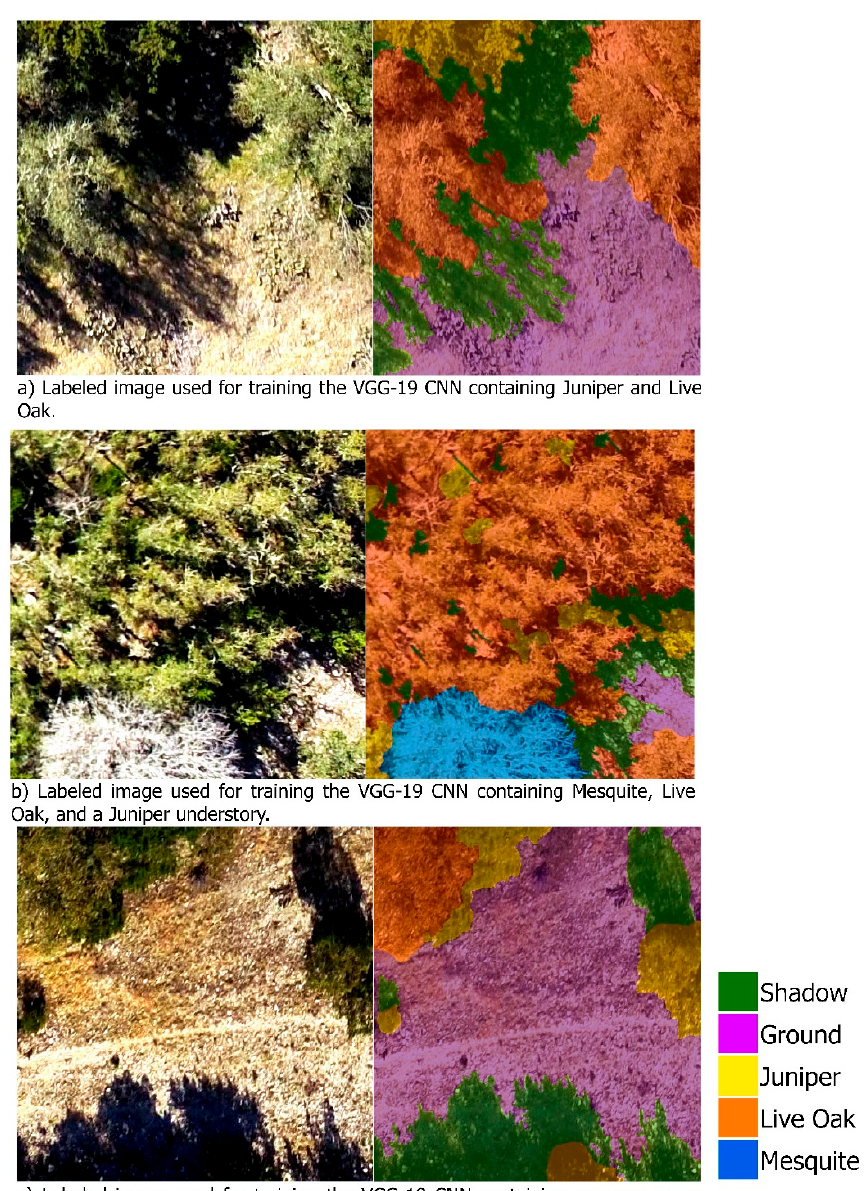
Figure 6. Labeled training images used to run the VGG-19 CNN. Images were carefully selected to accurately represent the class features in our study area. ( a ) A labeled image containing juniper and live oak, as well as some open area. ( b ) A labeled image containing a heavily forested scene with all three woody plant species. ( c ) A labeled image containing an open area, juniper, live oak, and large shadows.